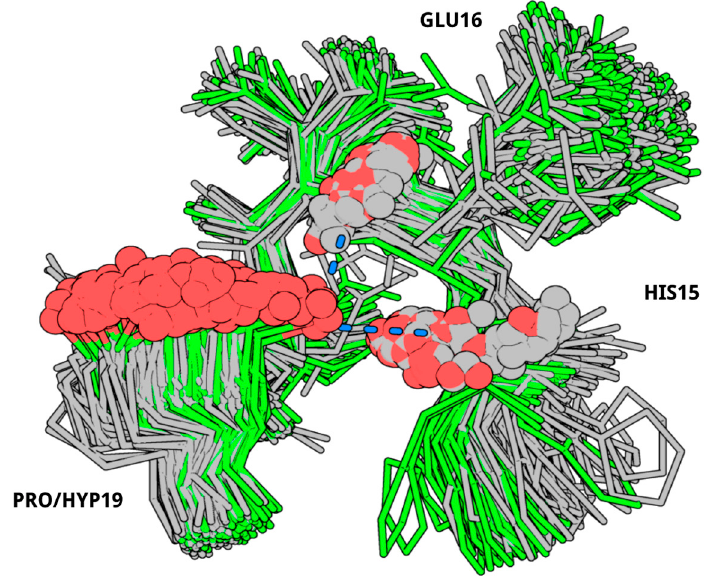
Figure 6. Clustered loop conformations. Spheres depict the donors and the acceptors of the hydrogen bond (WT is in grey, HYP is in green with red spheres, hydrogen bonds are colored with blue.